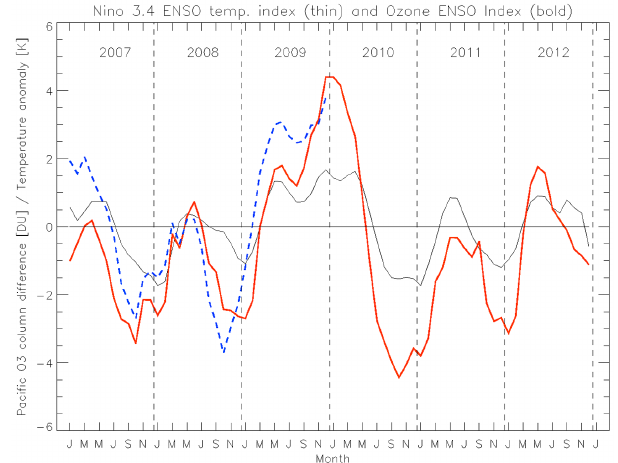
Figure 10. Time series of the Ozone ENSO index (bold lines) versus Niño 3.4 SST index (thin black line). The solid red line denotes the OEI derived from the GOME-2 TOC data, the dashed blue line shows the OEI derived from EMAC